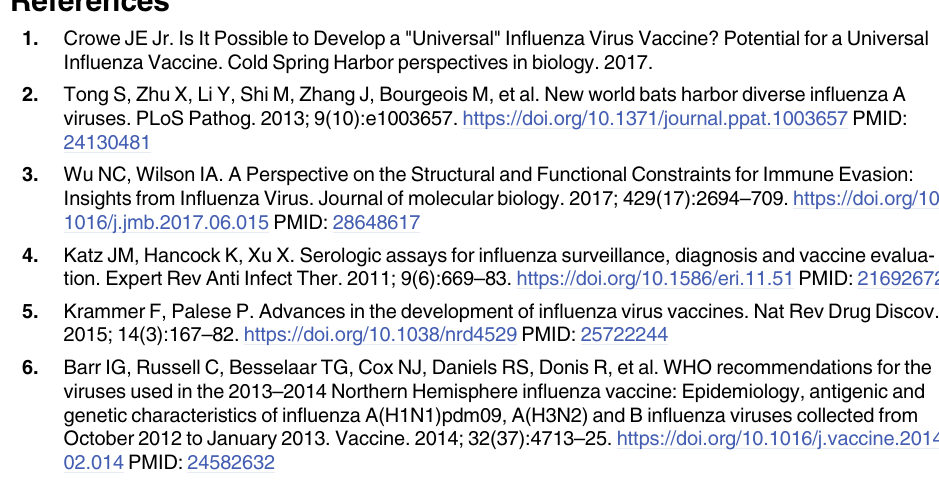
S5 Fig. HRP-conjugated Goat anti mouse IgG (SB) (HRP-GAM IgG) does not cross-react with human IgG standard (200 ng/well) at 1:2000 working dilution. The plate was coated with human IgG standard (200 ng/well) that was detected by HRP-conjugated goat anti human IgG (HRP-GAH IgG), but was not by HRP-GAM IgG. (TIFF) S6 Fig. Inhibition of H2 rHA (200 ng/well) low pH conformational change by C179.